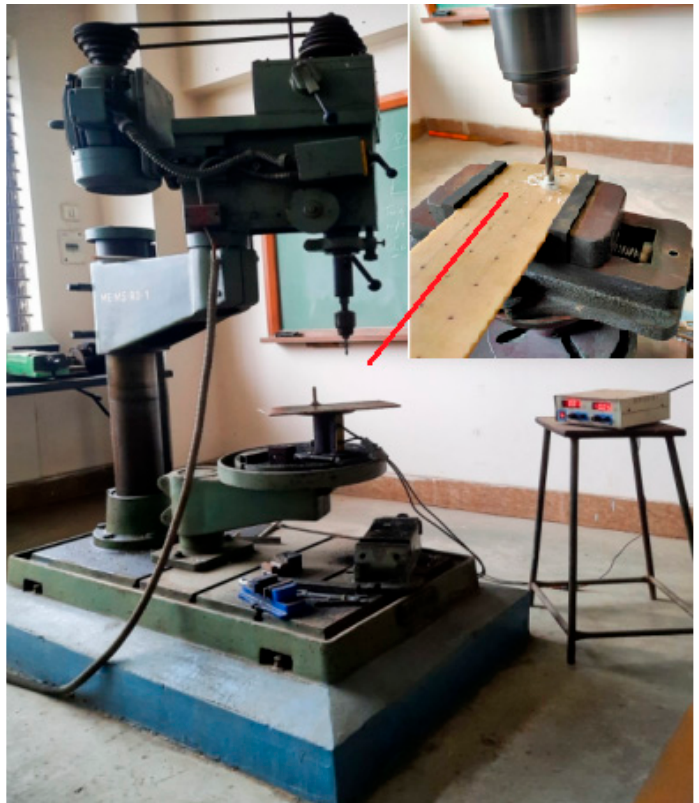
Processes 2022 , 10 , x FOR PEER REVIEW Figure 3. Actual setup of drilling operation with dynamometer. Figure 3. Actual setup of drilling operation with dynamometer.